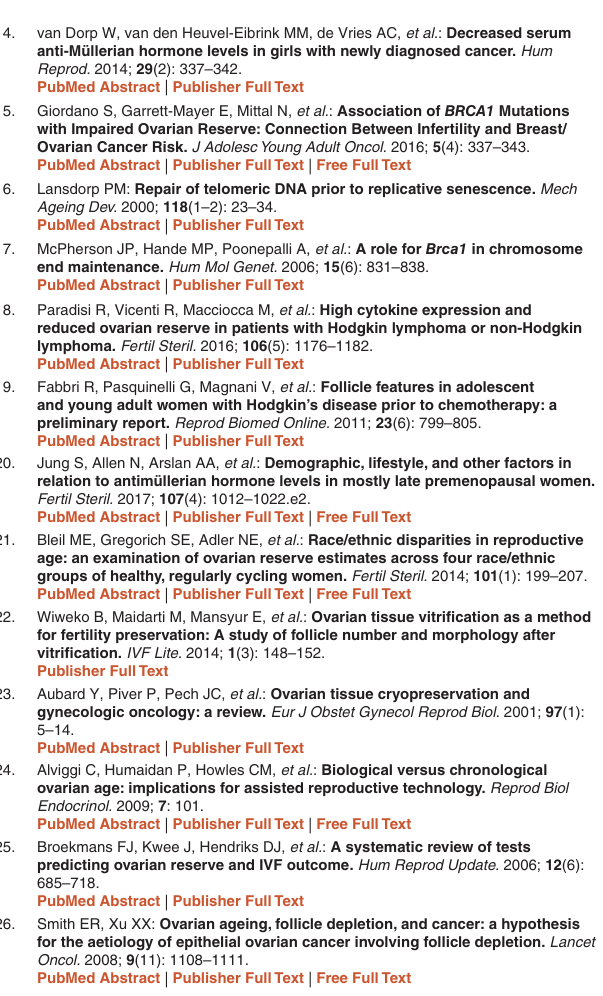
Figshare: Anti-Mullerian hormone levels in female cancer patients of reproductive age in Indonesia: A cross-sectional study,